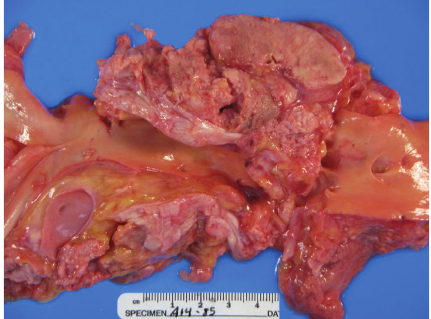
Figure 3: The supraclavicular lymph node was entirely effaced by sheets of highly pleomorphic epithelioid cells with enlarged hyperchromatic nuclei, focal cytoplasmic vacuolization, and areas (not pictured here) of necrosis.